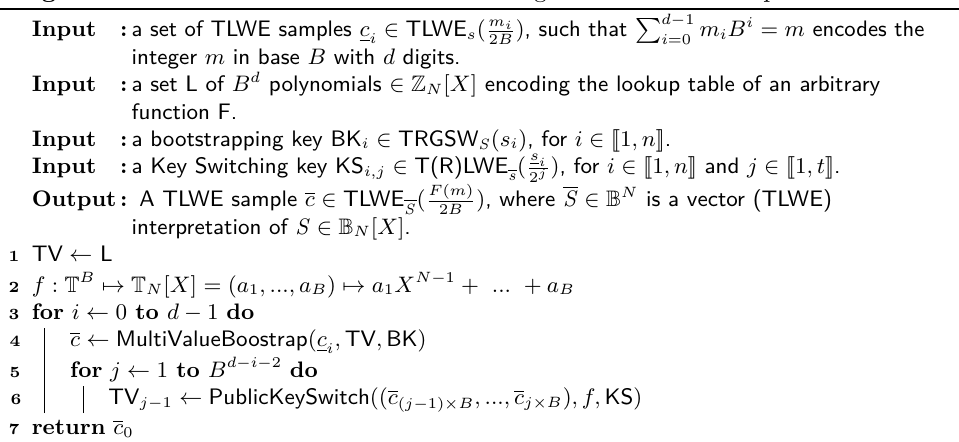
Algorithm 6: Tree-based method for combining functional